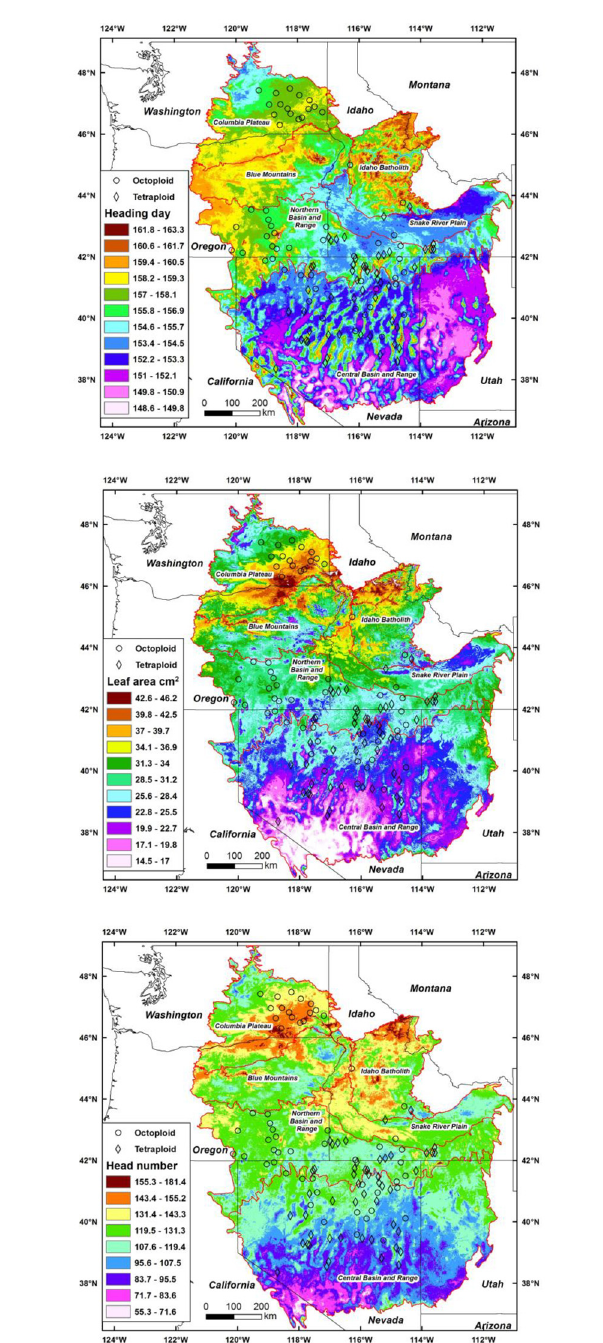
Fig 1. Maps of regression models for heading day, leaf area, and head number with climate variables for basin wildrye in the intermountain west. Omernik ecoregion boundaries are shown as red lines. The different colored areas were delimited with contours based on the ± P = 0.01 confidence interval from the regression model error term. Model predictions outside the range of trait values were not mapped (shown in